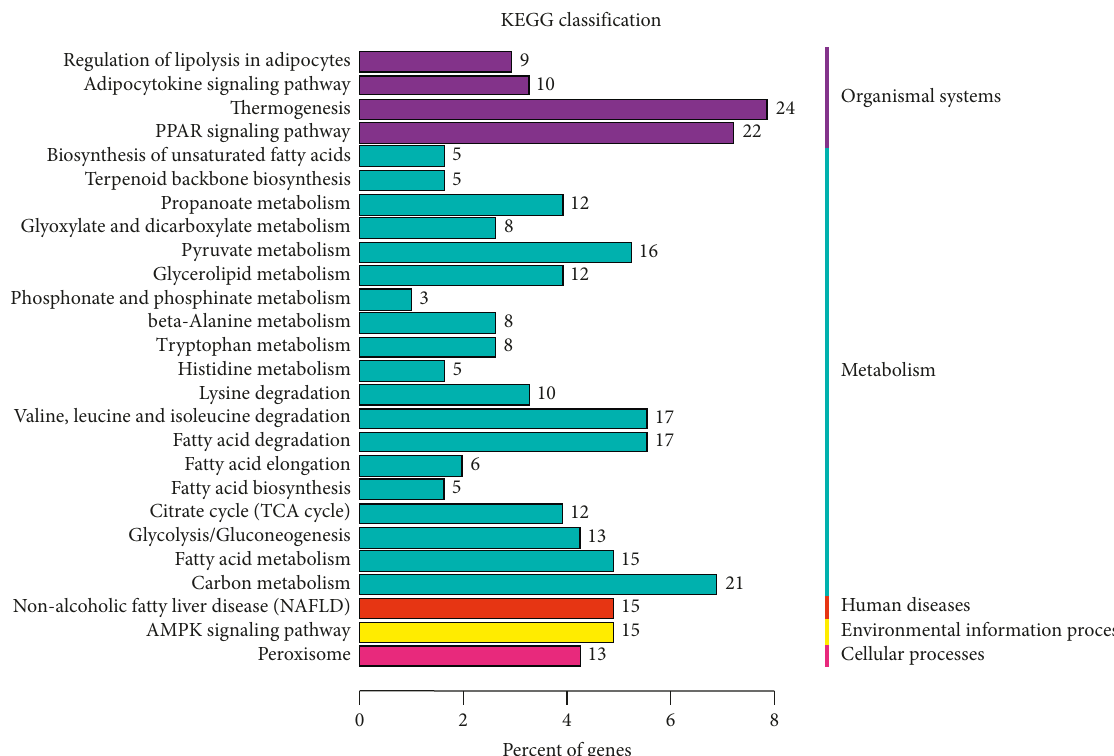
Figure 3: Distribution of differentially expressed genes in representative pathways as compared between InG and V2. KEGG enrichment analysis (http://www.kegg.jp/kegg/kegg1.html) was performed to identify the pathways. InG: GNPDA2 shRNA knockdown ADMSCs; V2: the control cells of